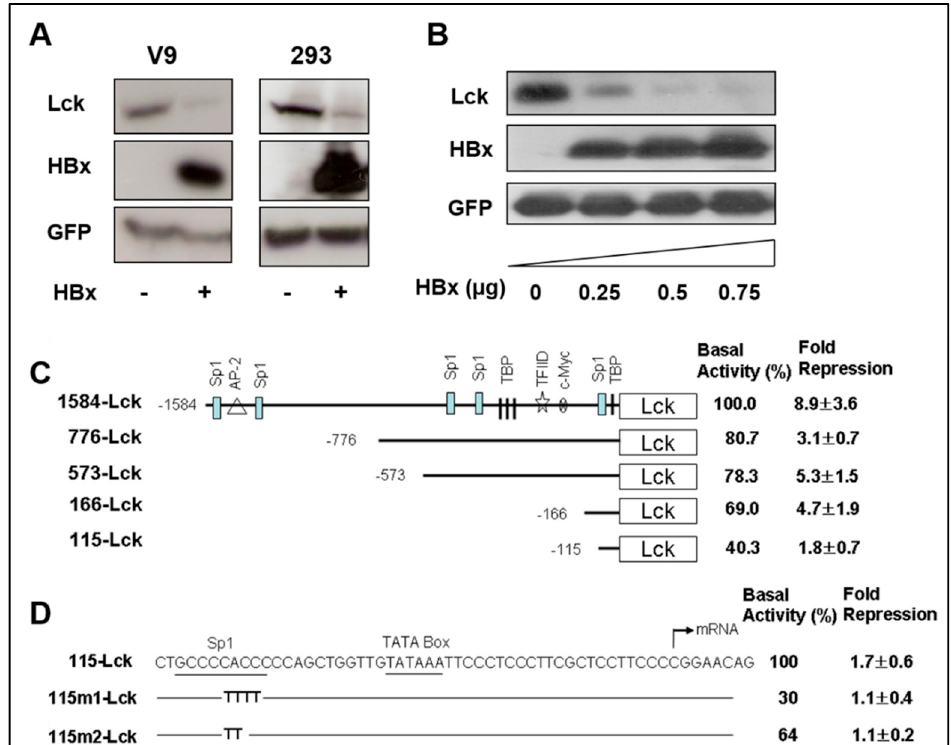
Figure 2. Repression of the SELENBP1 promoter by HBx. (A) HBx expression plasmid or control plasmid was co-transfected into Chang V9 and HEK293 cells with Lck plasmid. Plasmid Myk-eGFP was used for normalizing the transfection efficiency, and pcDNA3.1 was used as a negative control. Two days after transfection, cell lysates were analyzed by Western blotting for investigation of the HBx-mediated down-regulation of SELENBP1 promoter. ( B ) HEK293 cells were co-transfected with 0, 0.25, 0.5, and 0.75 µ g of pRcCMV-HBx and Lck expression reporter plasmid. Two days after transfection, expression levels of Lck, HBx, and GFP in the transfected cells were determined by Western blot analyses. Representative bands are shown after 3 independent experiments. ( C ) The 1584-bp length SELENBP1 promoter and its truncated constructs are schematically shown, and positions